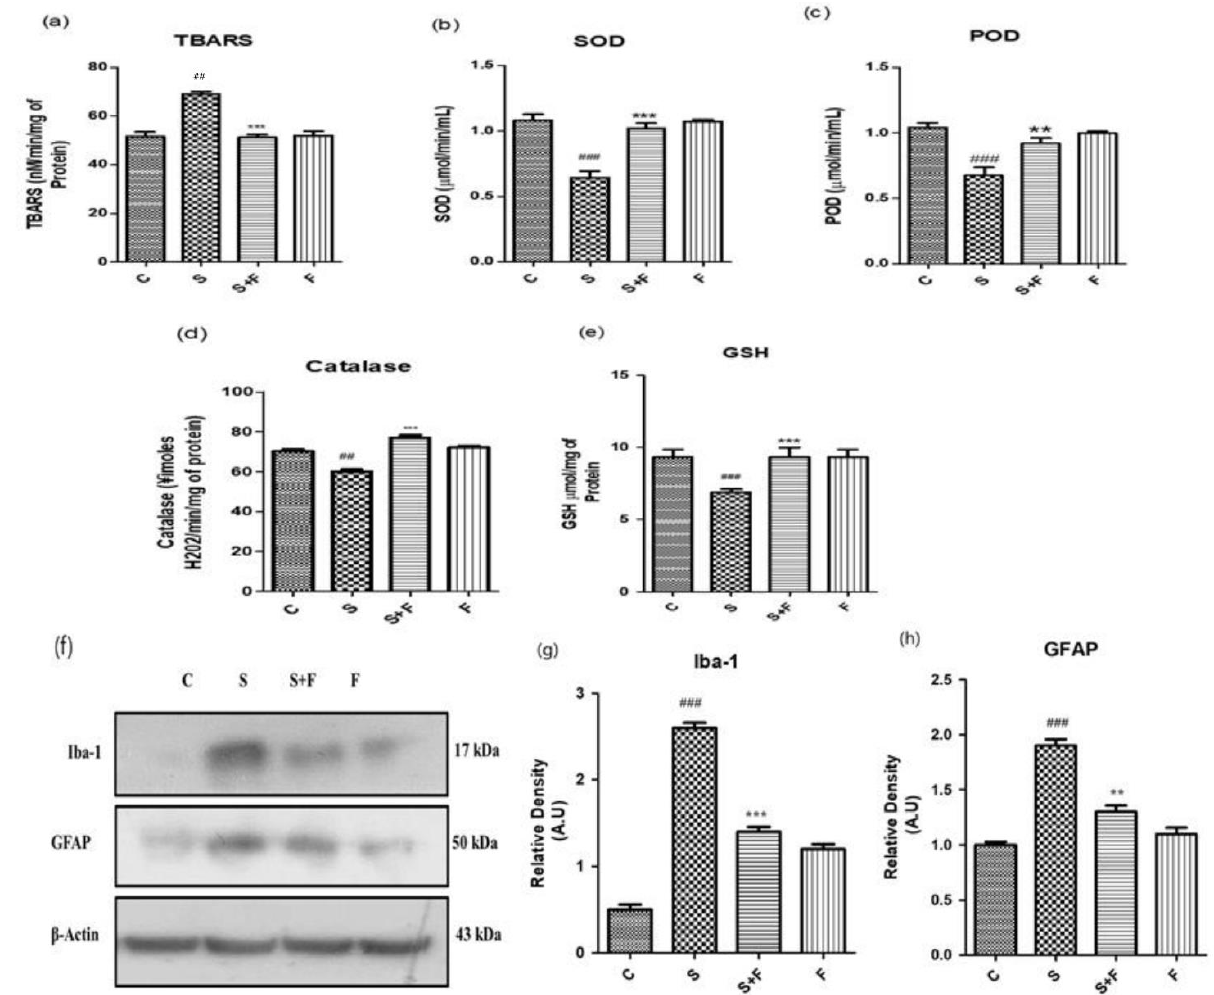
Figure 2. Friedelin abolished scopolamine-induced oxidative stress and glial cell activation in adult mice brain. Shown are the different antioxidant enzyme assays ( a ) Lipid peroxidase, TBARS ( b ) Superoxide dismutase, SOD ( c ) peroxidase enzyme, POD ( d ) Catalase enzyme, CAT and ( e ) Glutathione, GSH performed with brain homogenates of experimental mice treated either with scopolamine alone or in combination with friedelin, respectively. ( f ) Shown are western blot bands of glial cells along with respective histograms at ( g , h ). The treatment details have already been given in the materials and methods section. The results are stated as Mean ± S.E.M ( n = 5). Significance of control vs. scopolamine is expressed as # , while * denotes scopolamine Vs scopolamine + friedelin. Significance: ** , ## p < 0.01 and *** , ### p < 0.001.